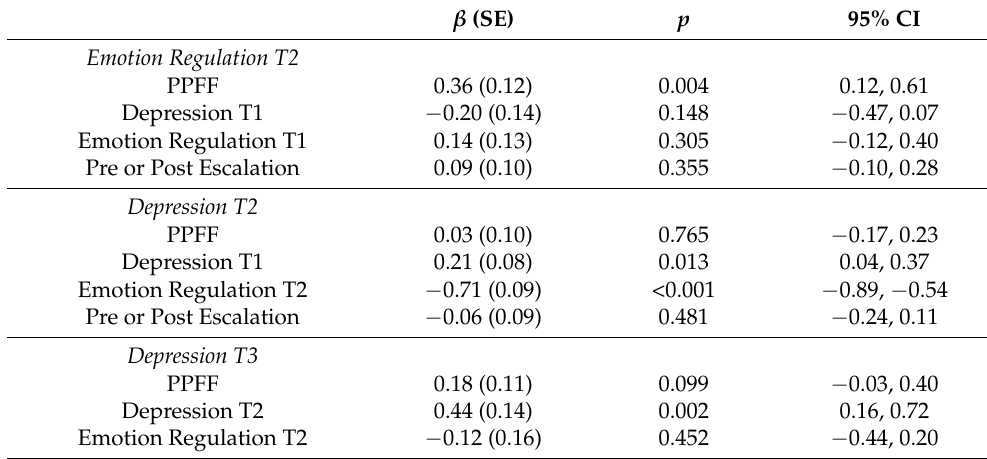
Table 2. Indirect effects model: Fathers’ emotion regulation and